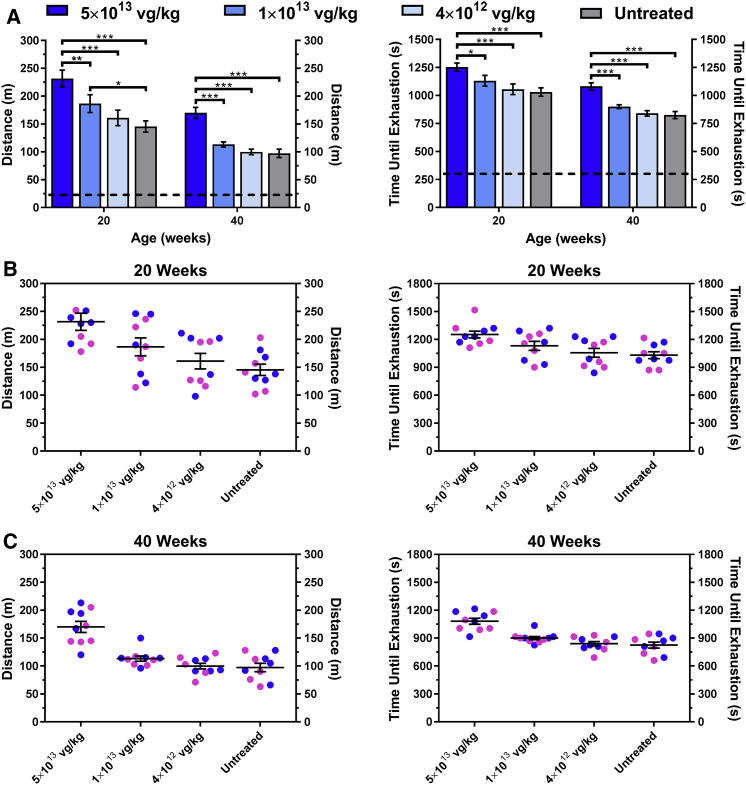
Improvement in Muscle Performance Is Dose Dependent(A) Treadmill exhaustion test assessing the running distance (left) and time until exhaustion (right) of the AAV9-FKRP-treated (5 × 1013, 1 × 1013, 4 × 1012 vg/kg) and untreated FKRPP448L cohorts (n = 10) conducted at 20 and 40 weeks of age. The dashed line represents the acclimation period (∼24 m, 300 s). Error bars represent mean ± SEM. *p ≤ 0.05, **p ≤ 0.01, ***p ≤ 0.001, two-way ANOVA, Šidák correction for multiple comparisons using statistical hypothesis testing. Gender grouping (male, blue; female, pink) for each cohort detailing the running distance (left) and time until exhaustion (right) at (B) 20 and (C) 40 weeks of age. Error bars represent mean ± SEM.